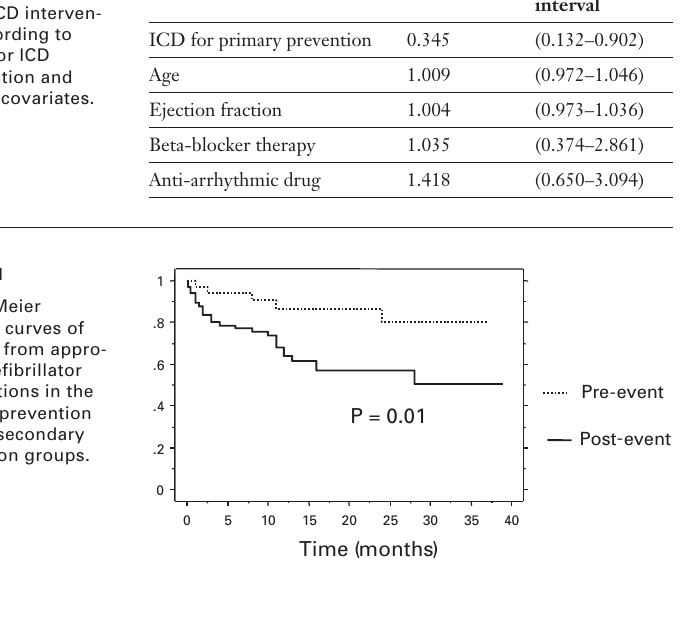
Risk of ICD interven- tion according to reason for ICD implantation and relevant covariates.